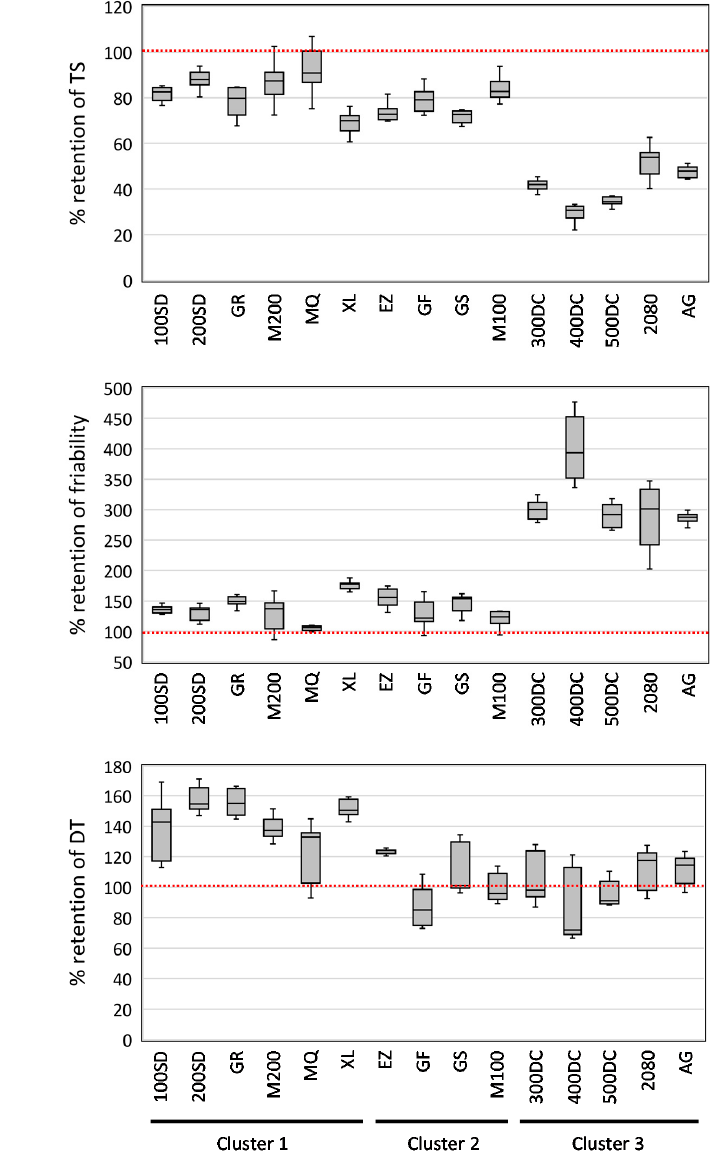
Figure 4. Box plots of the % retention from the pre-storage levels of TS ( A ), friability ( B ), and DT ( C ) as a function of mannitol grades. The lower and upper ends of the rectangular box represent the first and third quartiles of the variables, a horizontal line in the interior of the box expresses the median, and the lower and upper ends of the whiskers indicate the minimum and maximum of the variables, respectively.